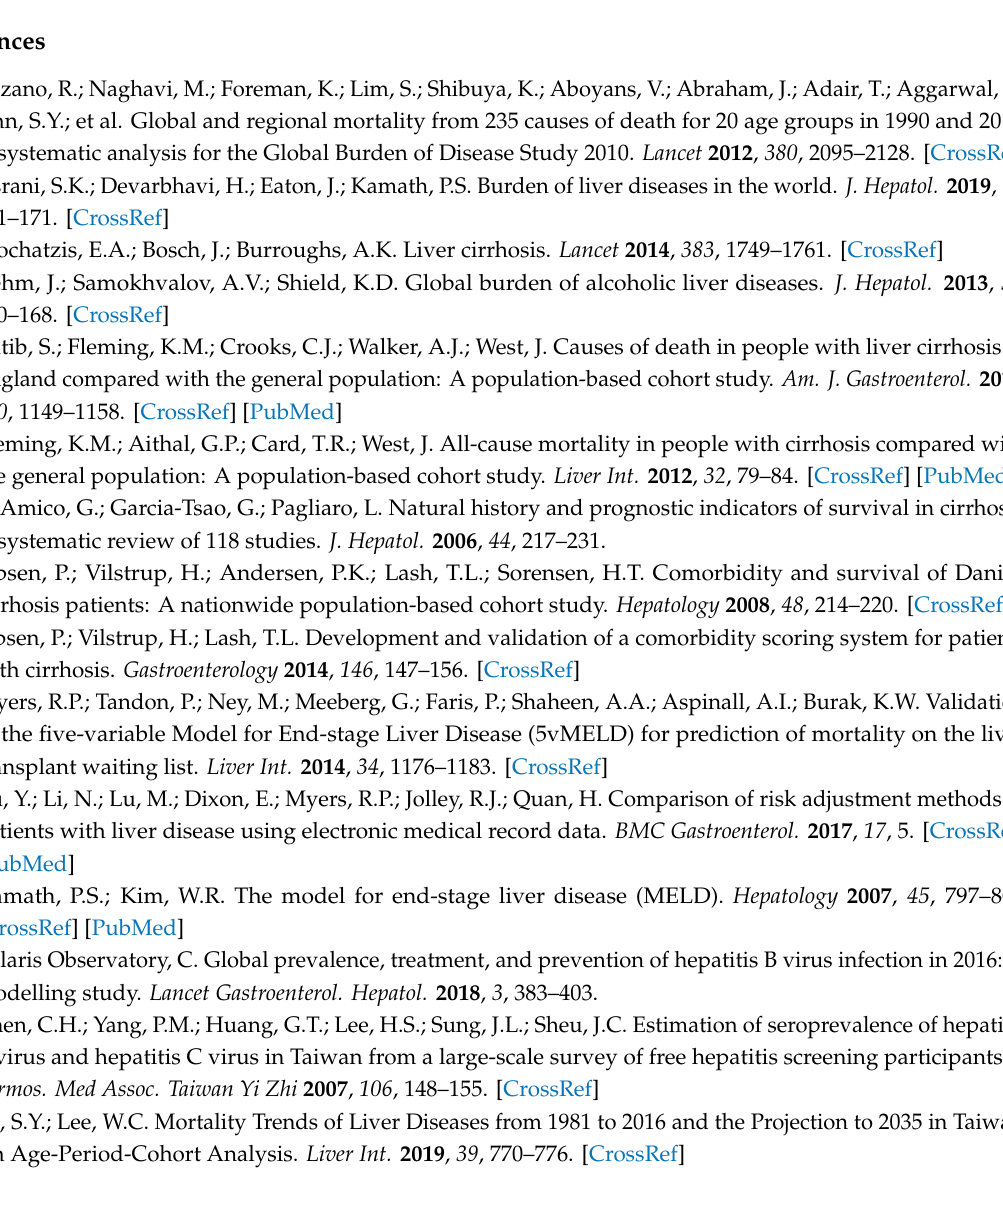
Table S1: ICD-9-CM diagnosis codes for comorbidities and complications; Table S2: Multivariable Cox proportional hazards model for complications of LC and survival